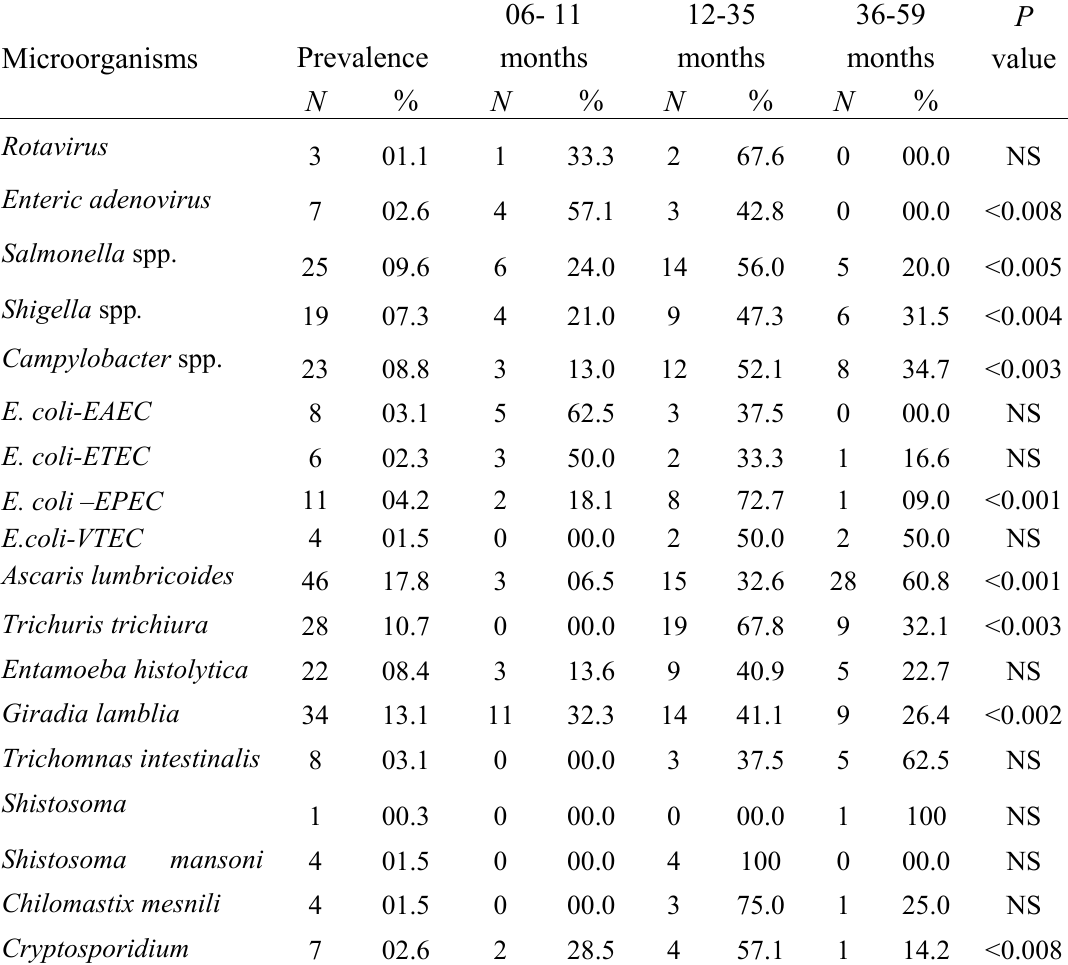
Table 4. Frequency and age distribution of micro organisms isolated from fecal samples of children with